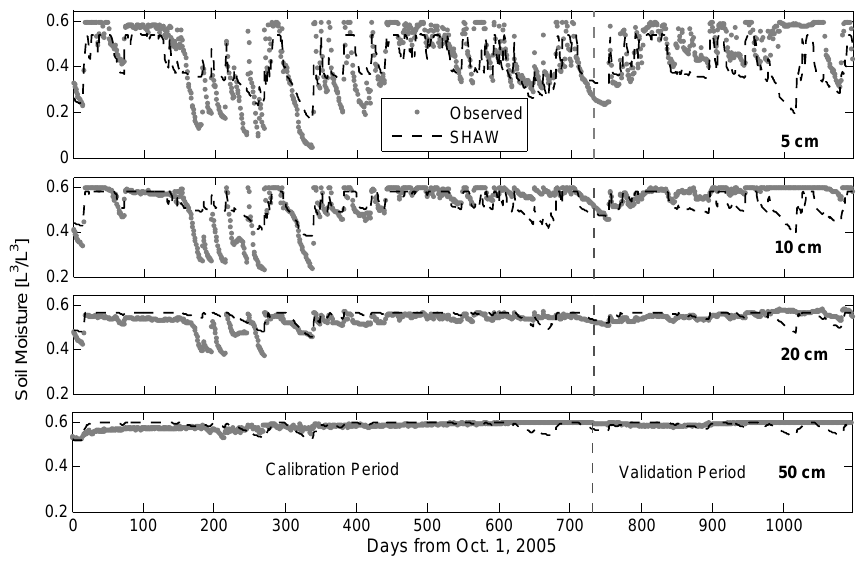
Figure 5. Observed vs. SHAW-simulated volumetric soil moisture [L 3 L − 3 ] at Site